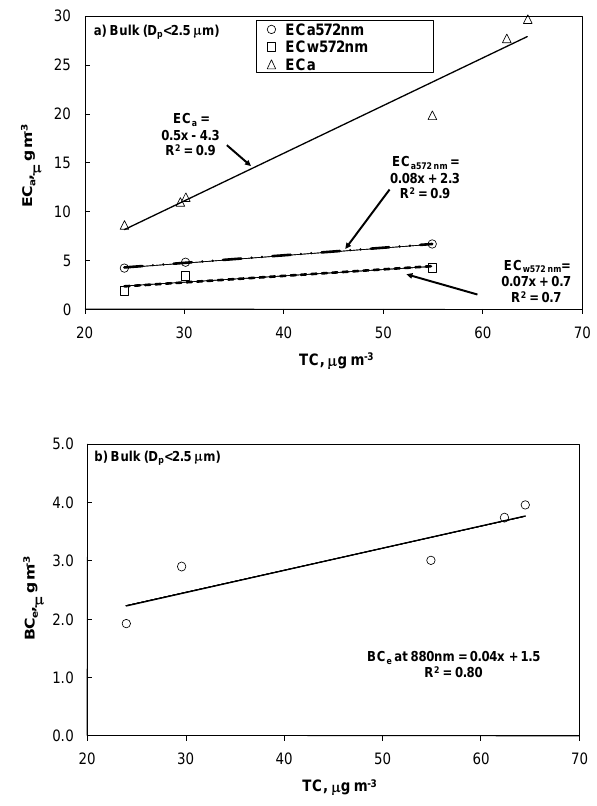
Fig. 6. (a) EC a (EC a , EC a572nm (non-extracted), EC w572nm (ex- tracted)) and (b) BC e880nm as a function of TC concentrations mea- sured for the fine aerosol ( D p < 2 . 5µm).